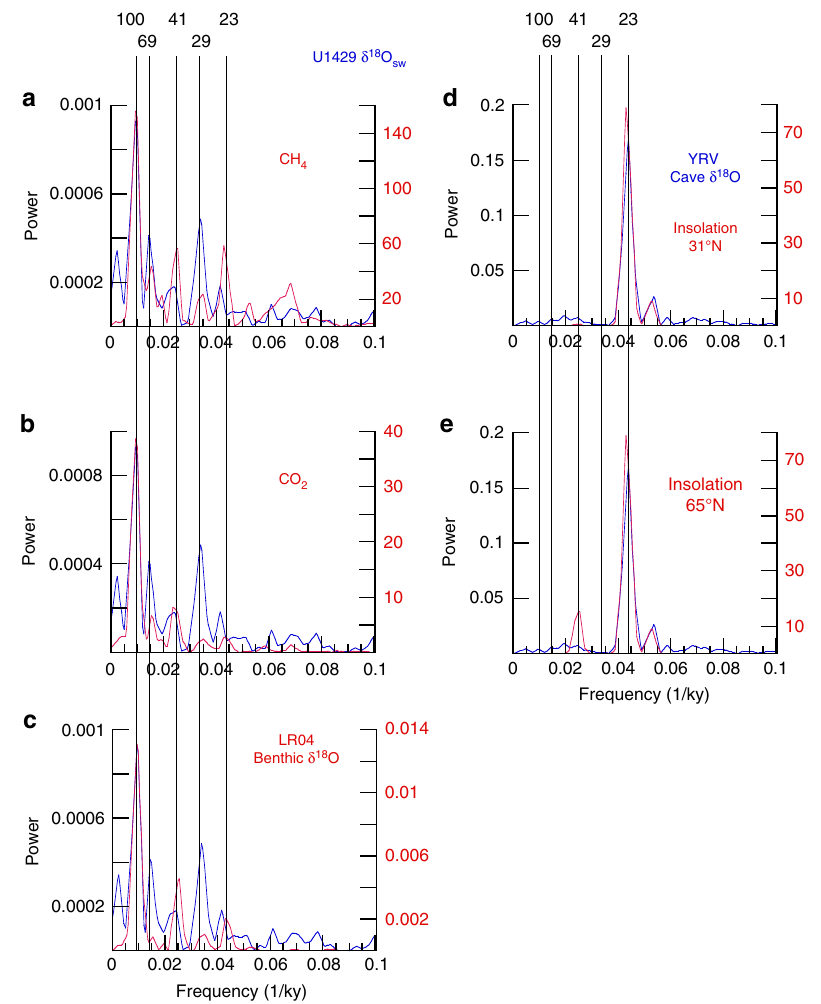
Fig. 5 Spectral comparisons of EAM proxy records with global ice volume, greenhouse gases, and insolation. Local δ 18 O sw , a record for which the effects of temperature and seawater δ 18 O have been removed, compared to a global CH 4 , b global CO 2 , and c global ice volume. δ 18 O cave , a record for which the effects of temperature and seawater δ 18 O have not been removed, compared to d local summer and e high-latitude summer-insolation forcing. Labeled lines denote primary orbital frequencies (frequency = 1/period in